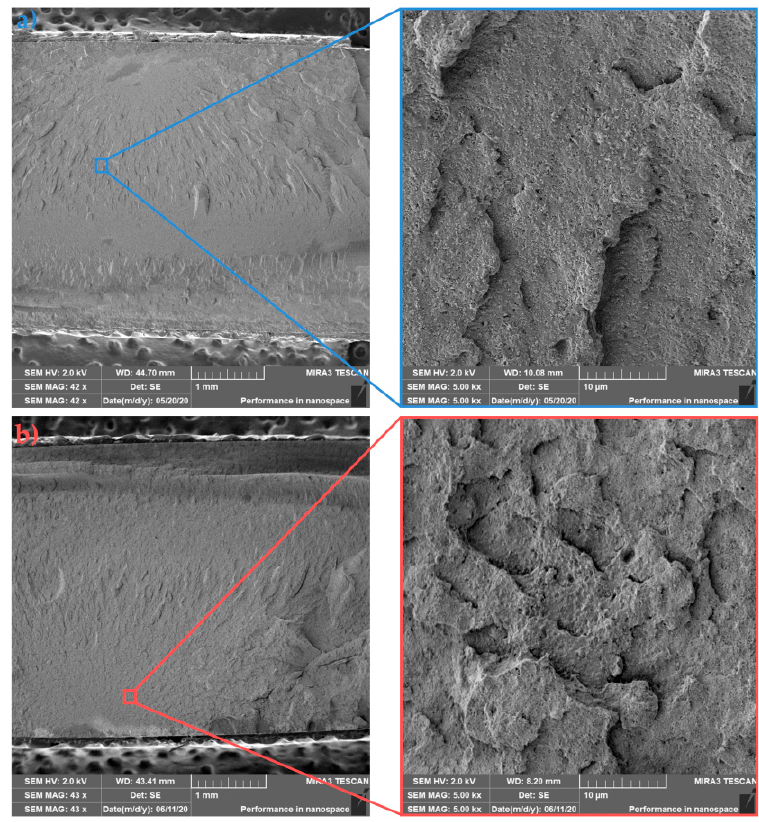
Figure 13. Fracture morphologies of ( a ) cold and ( b ) hot mold PLLA/15HA.